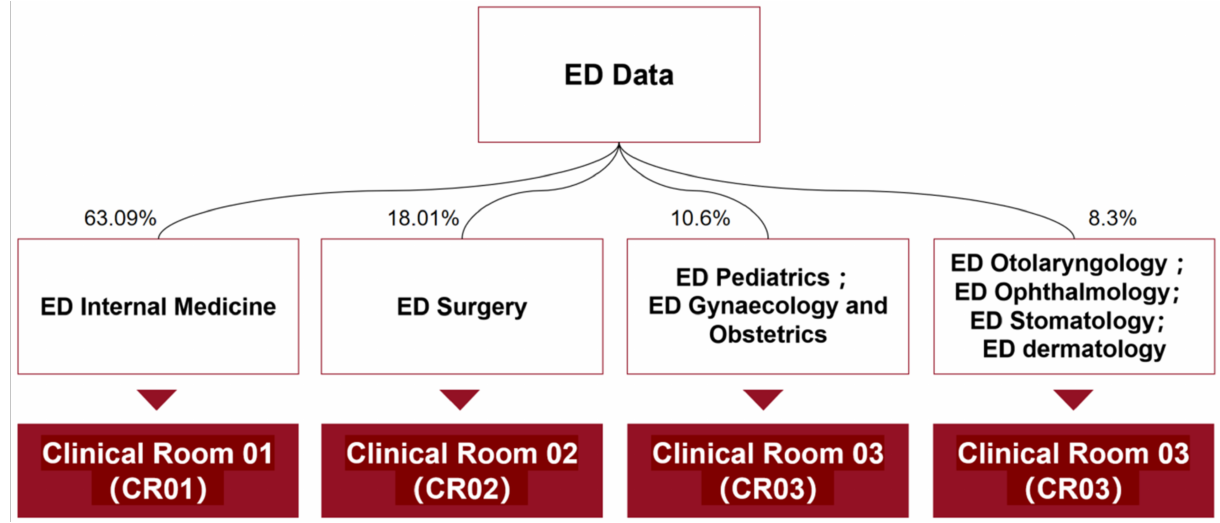
Figure 4. The first layer of categorization.